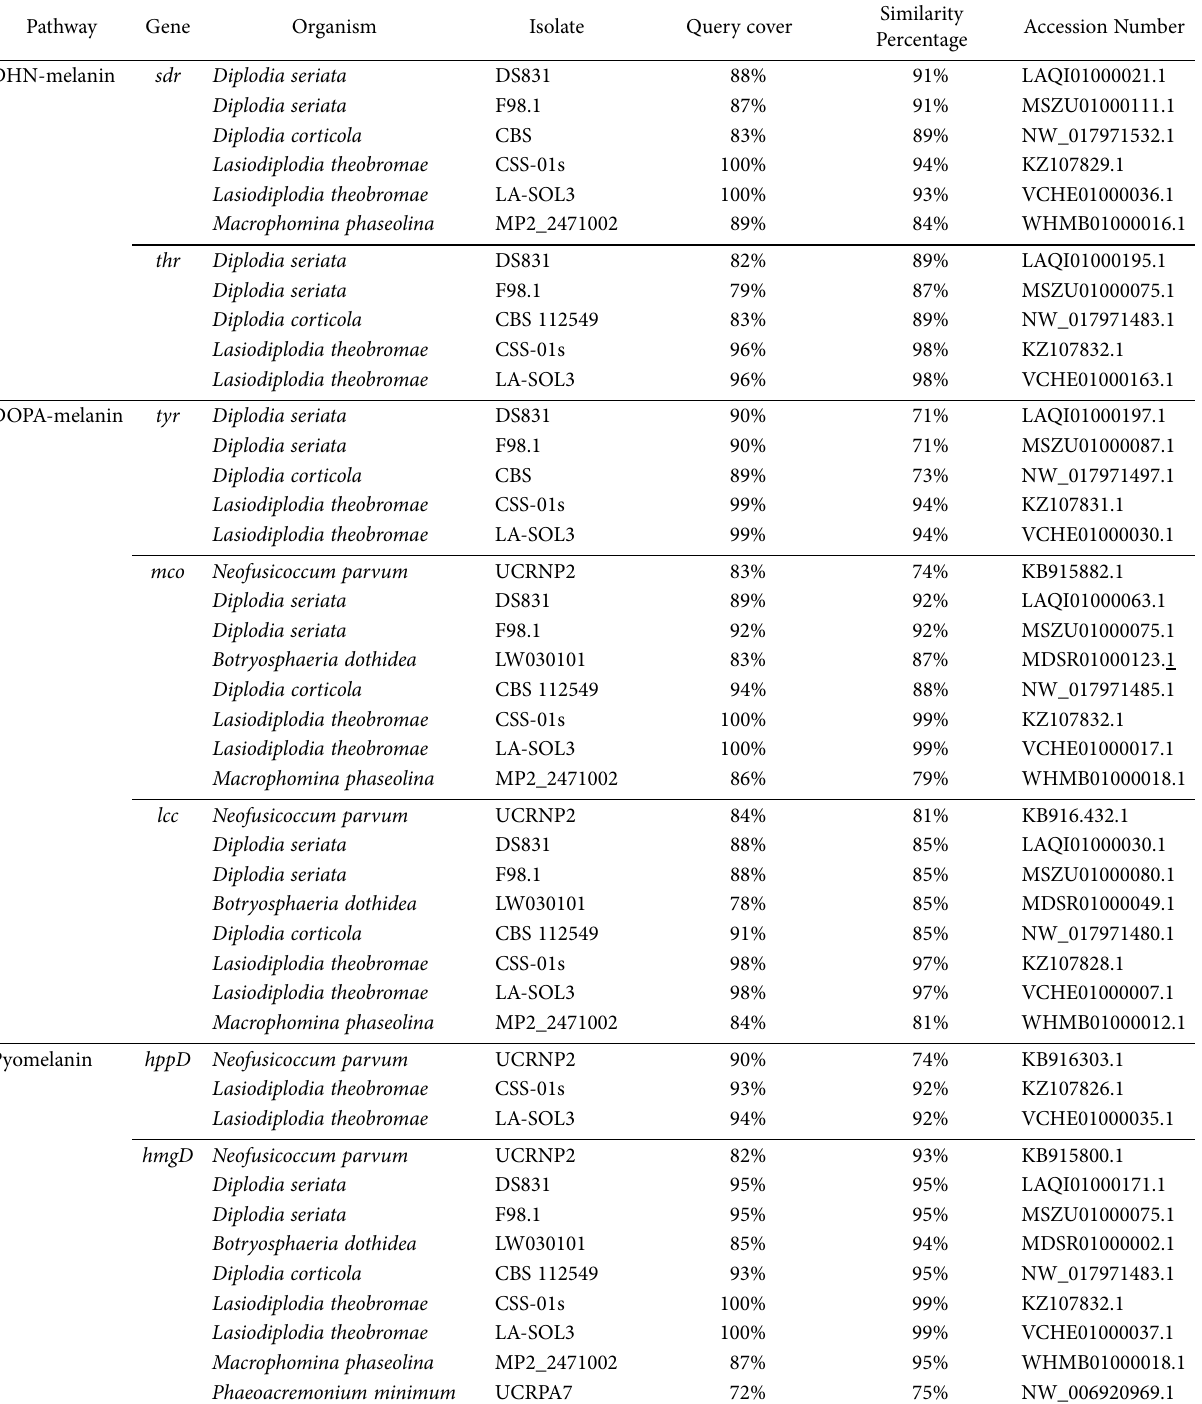
Table 1. Comparison of genes involved in the synthesis of melanin among genomes of the Botryosphaeriaceae , using tBLASTx analysis of similarity